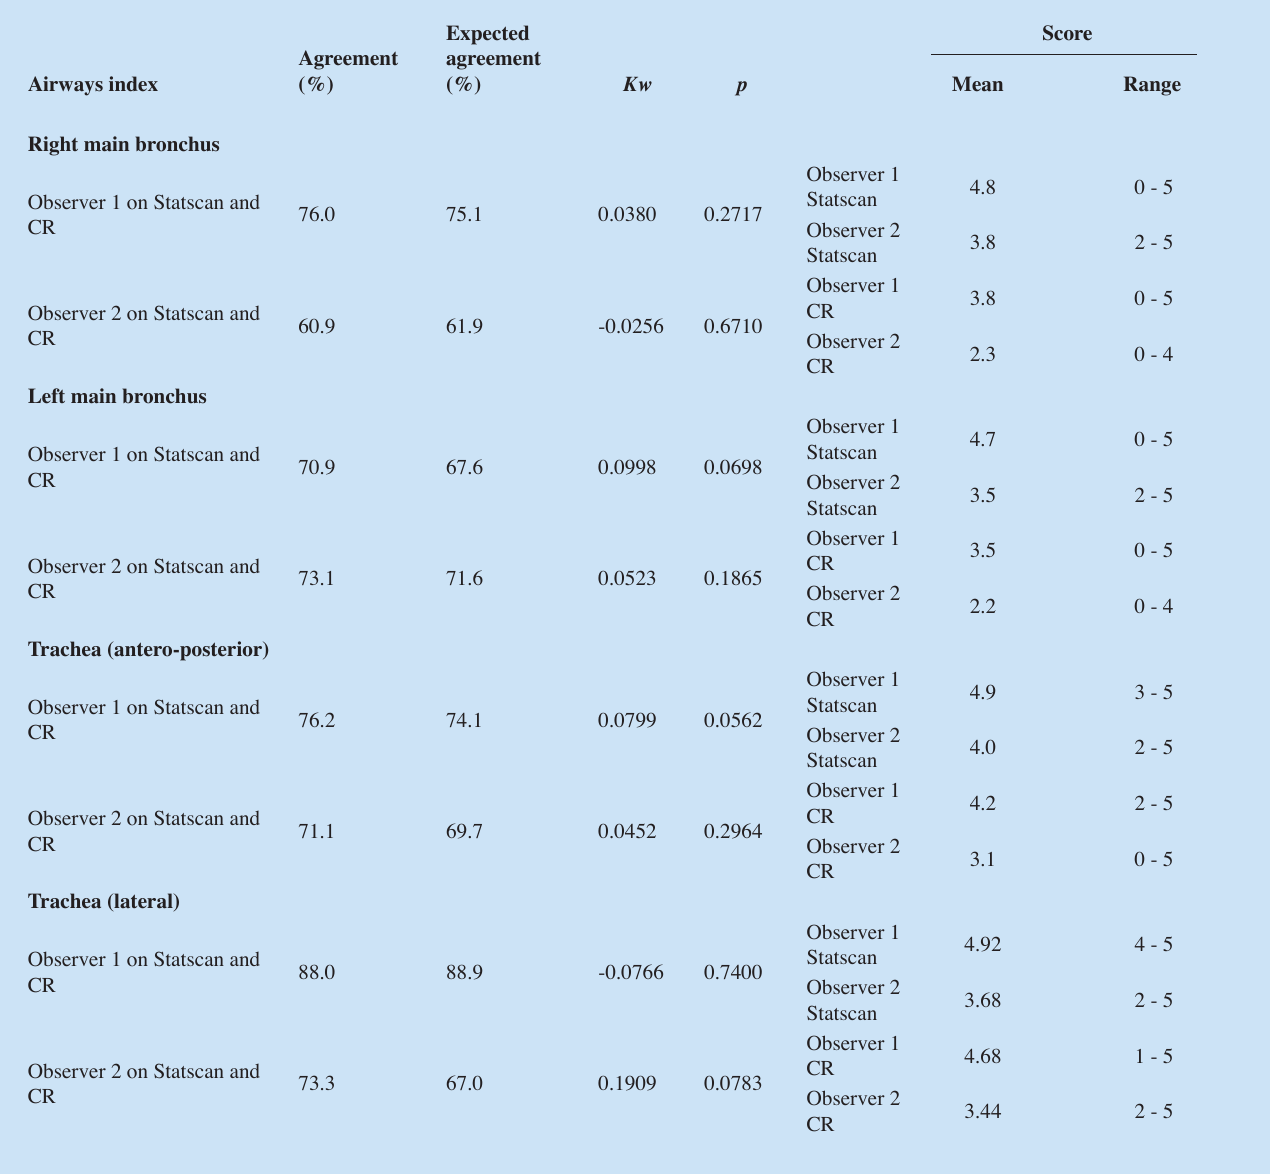
Table II. Assessment of agreement between observers and modalities for visualisation of the airways, as judged by the airways